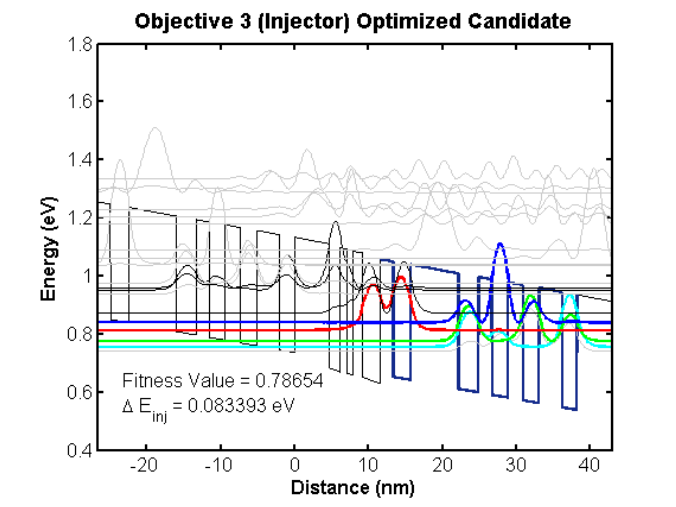
Figure 10. Al x Ga 1 − x As/In y Ga 1 − y As QC laser candidate simulated on GaAs (111) with top objective (3) fitness rank given a training initial population. Relevant wave functions, E inj , ij are in bold and colored.